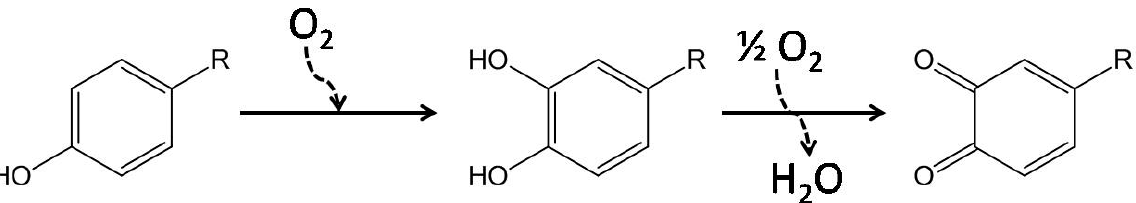
Figure 3. Main degradation steps of phenolic compounds.